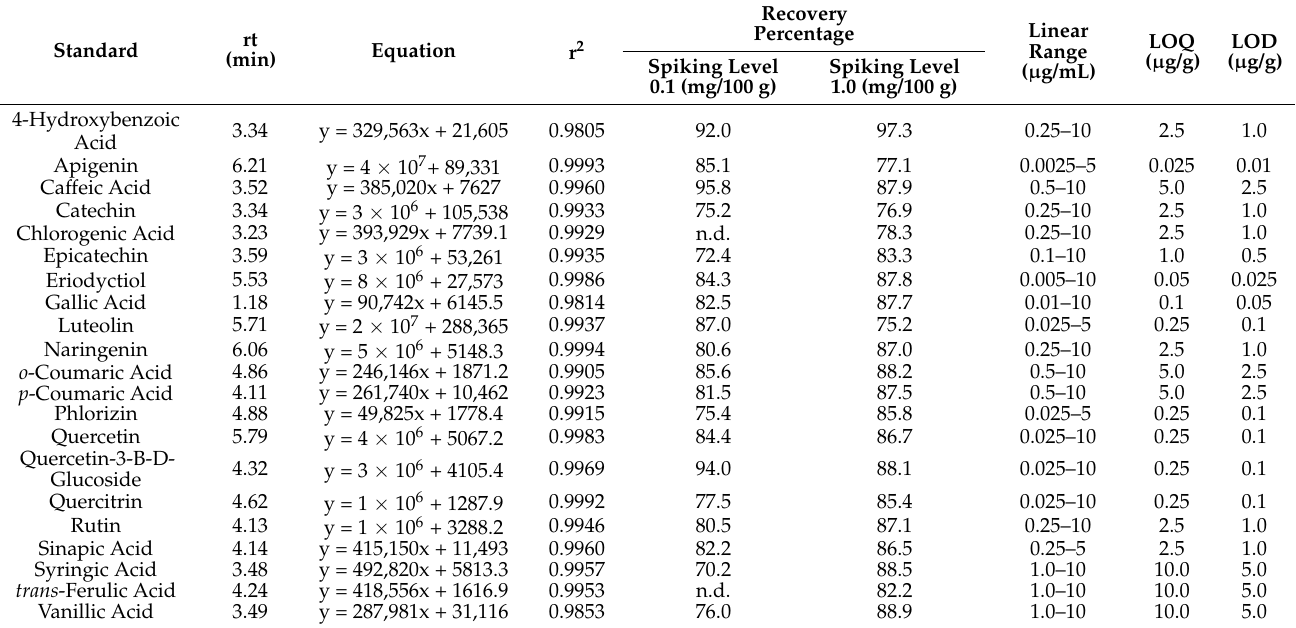
Table 7. Linearity, sensitivity and recovery percentages for the UHPLC-ToF-MS method. (n.d. = not